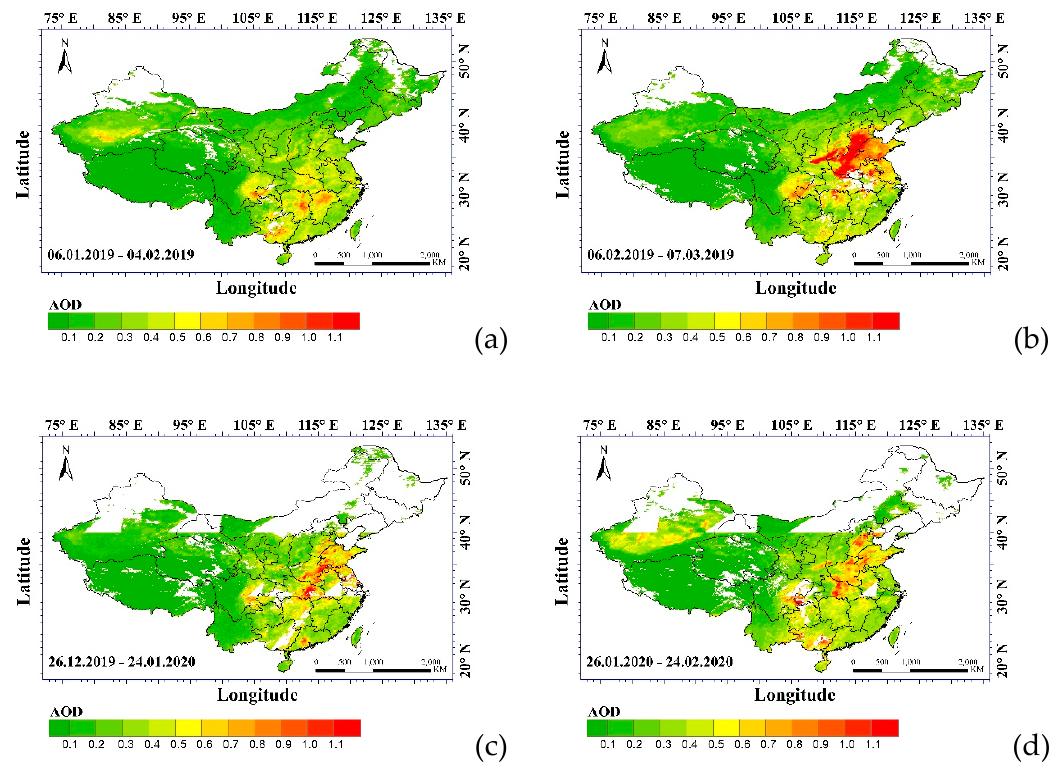
Figure 5. Same as Figure 2 but for AOD.